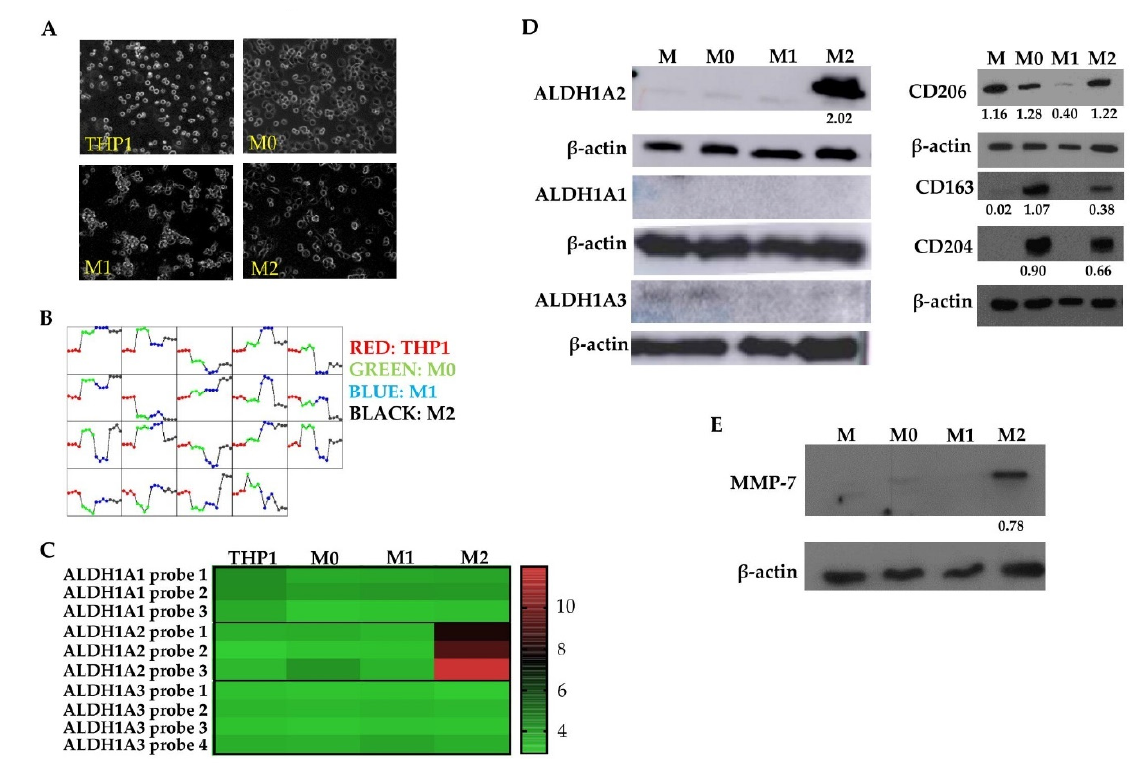
Figure 2. M2 macrophages highly express ALDH1A2 in a THP1 cell model system. ( A ) THP1 monocytic cells were differentiated to activated (M0), M1, and M2 states reflected by changes in morphology. ( B ) Comparison of dominant gene expression patterns between THP1 macrophage polarization states. ( C ) ALDH1A2 upregulation in M2 macrophages compared to other activation or polarization states ( p < 0.0001). Other ALDH1 family genes, ALDH1A1 and ALDH1A3 showed low to no expression in THP1 cells regardless of activation or polarization state. Results are representative of 4 arrays. Western blot of ( D ) ALDH1A2, ALDH1A1, ALDH1A3, CD206, CD163, CD204, (representative of at least 3 blots) and ( E ) MMP-7 (representative of 2 blots) immunoreactive proteins in THP1 cells (M: naïve cells, M0: activated with PMA, M1: activated, polarized with LPS, IFN γ , M2: activated, polarized with IL-4, IL-13). MMP-7 is only expressed in M2 macrophages in agreement with the gene expression array. Normalized densitometry is reported below the Western blot.